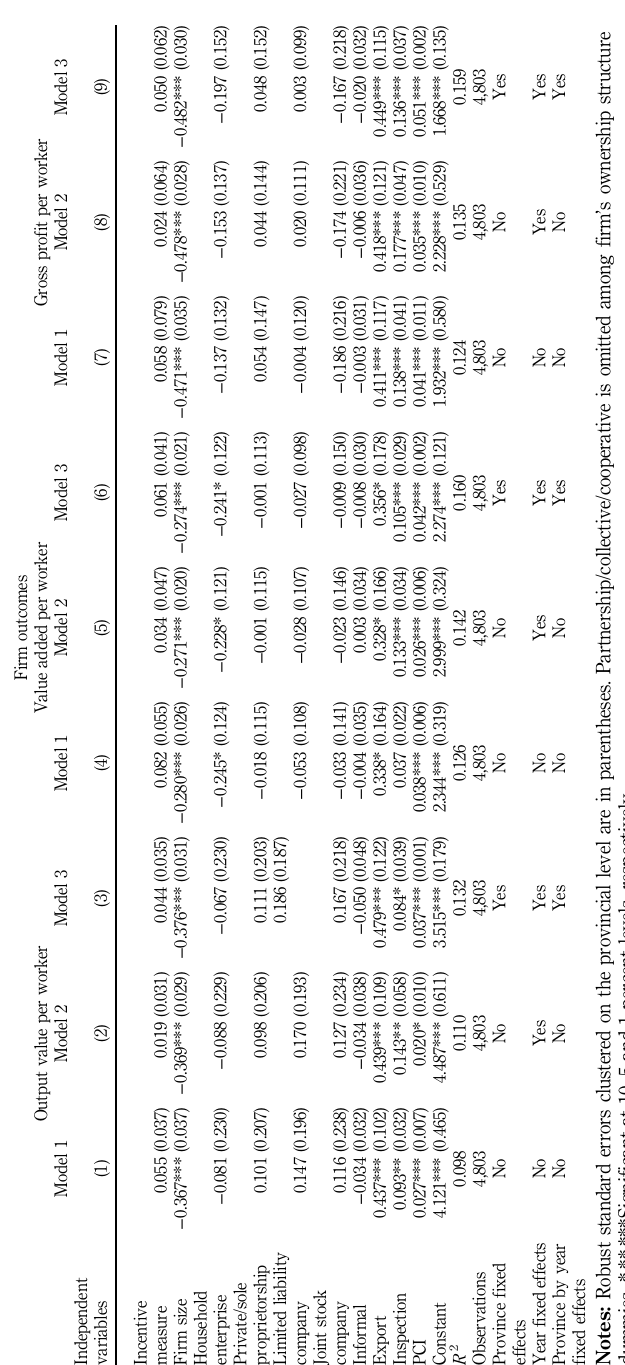
Table IV. Incentive measure